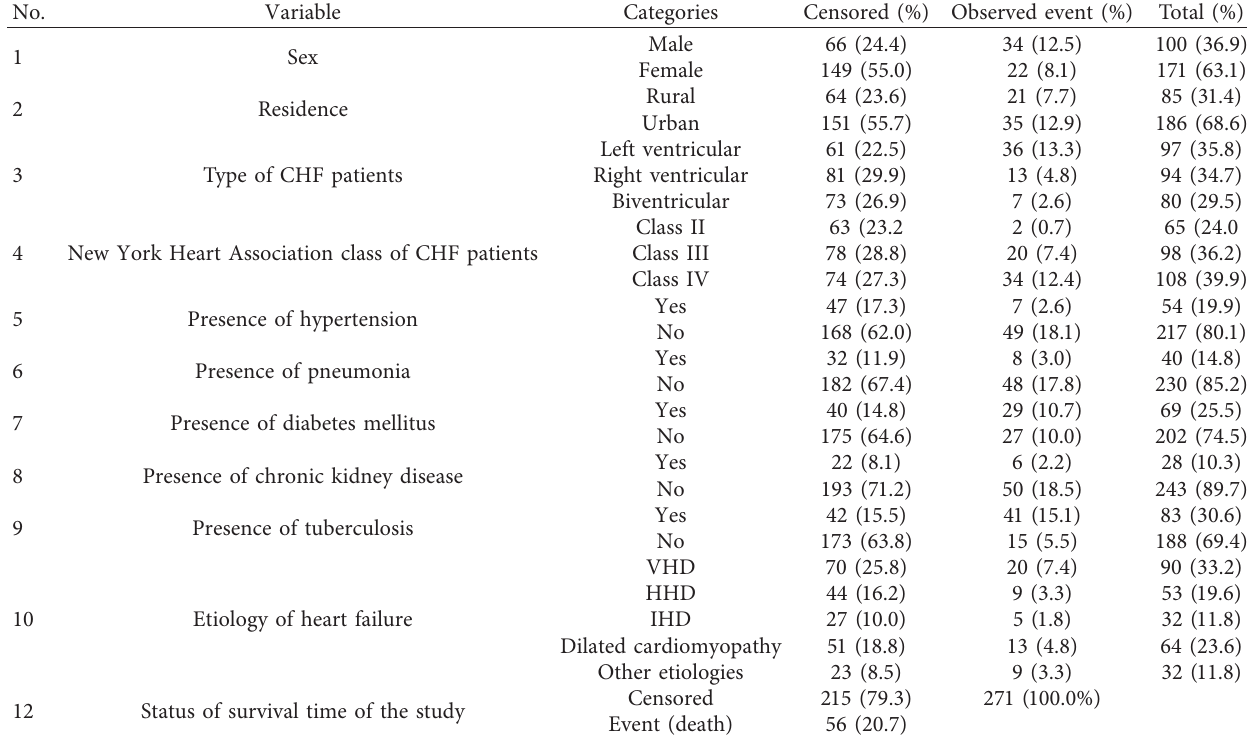
Table 1: Baseline categorical variable characteristics for CHF patients with DTRH from January 1, 2016, to December 31, 2019.